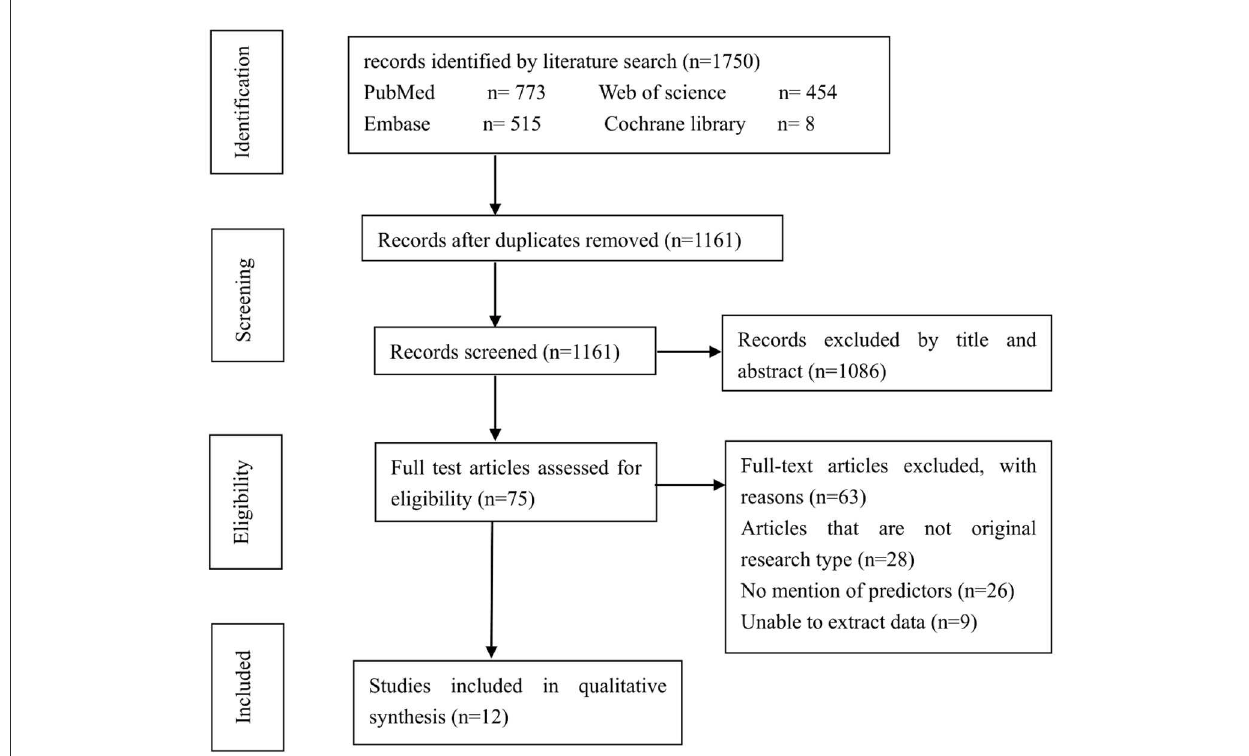
FIGURE1 Flow chart of the study